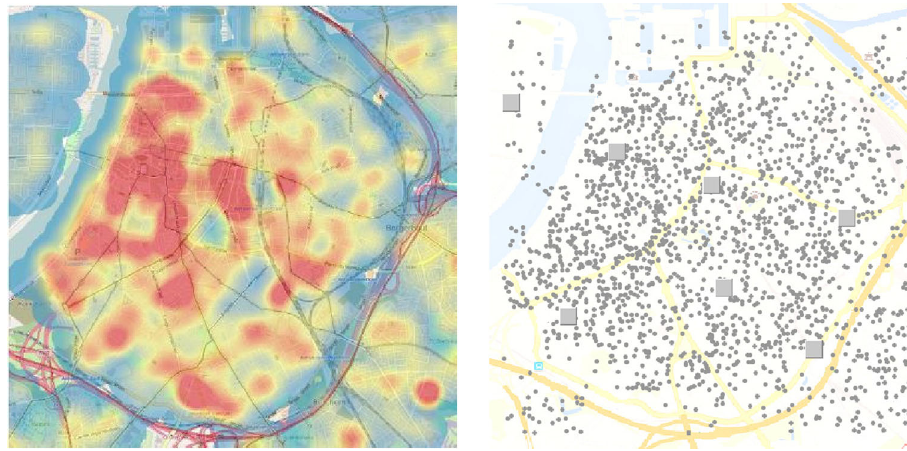
Fig. 1 Generation of customer locations and DPs (right) on the basis of actual demand (left, Source: